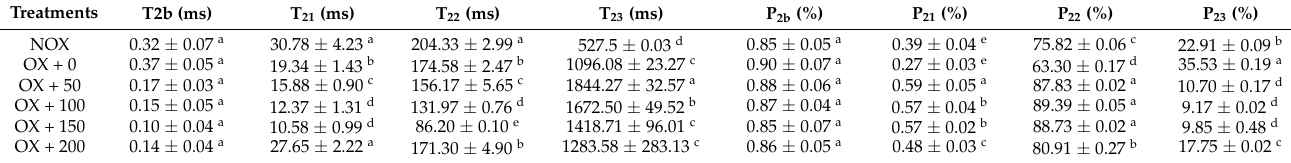
Table 4. Effect of oxidation and different concentrations of FOs (0, 50, 100, 150, and 200 µ mol/g protein) on T 2 relaxation time and percentage of T 2 relaxation time peak area of MP gel. Different lowercase letters indicate significant differences ( p <